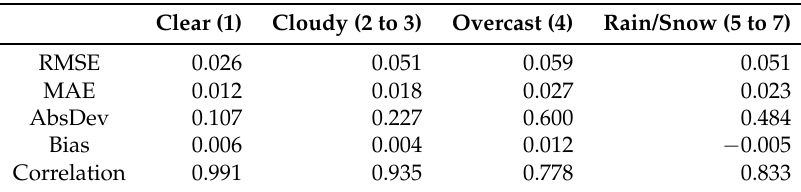
Table 9. Forecast performance in different weather indices.